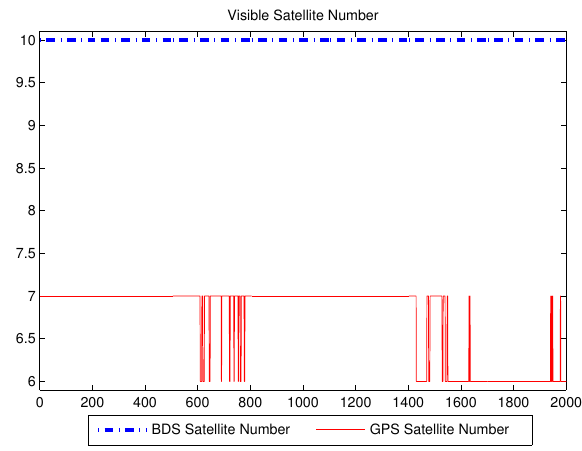
Figure 2. The number of visible satellites.